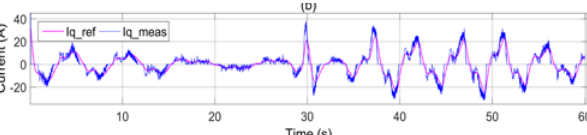
Fig. 12. The performance of PI-controller for Case II, 0-29 s, and Case III, 30-60s. (a) d-axis referenced and measured currents; (b) q- axis referenced and measured currents.